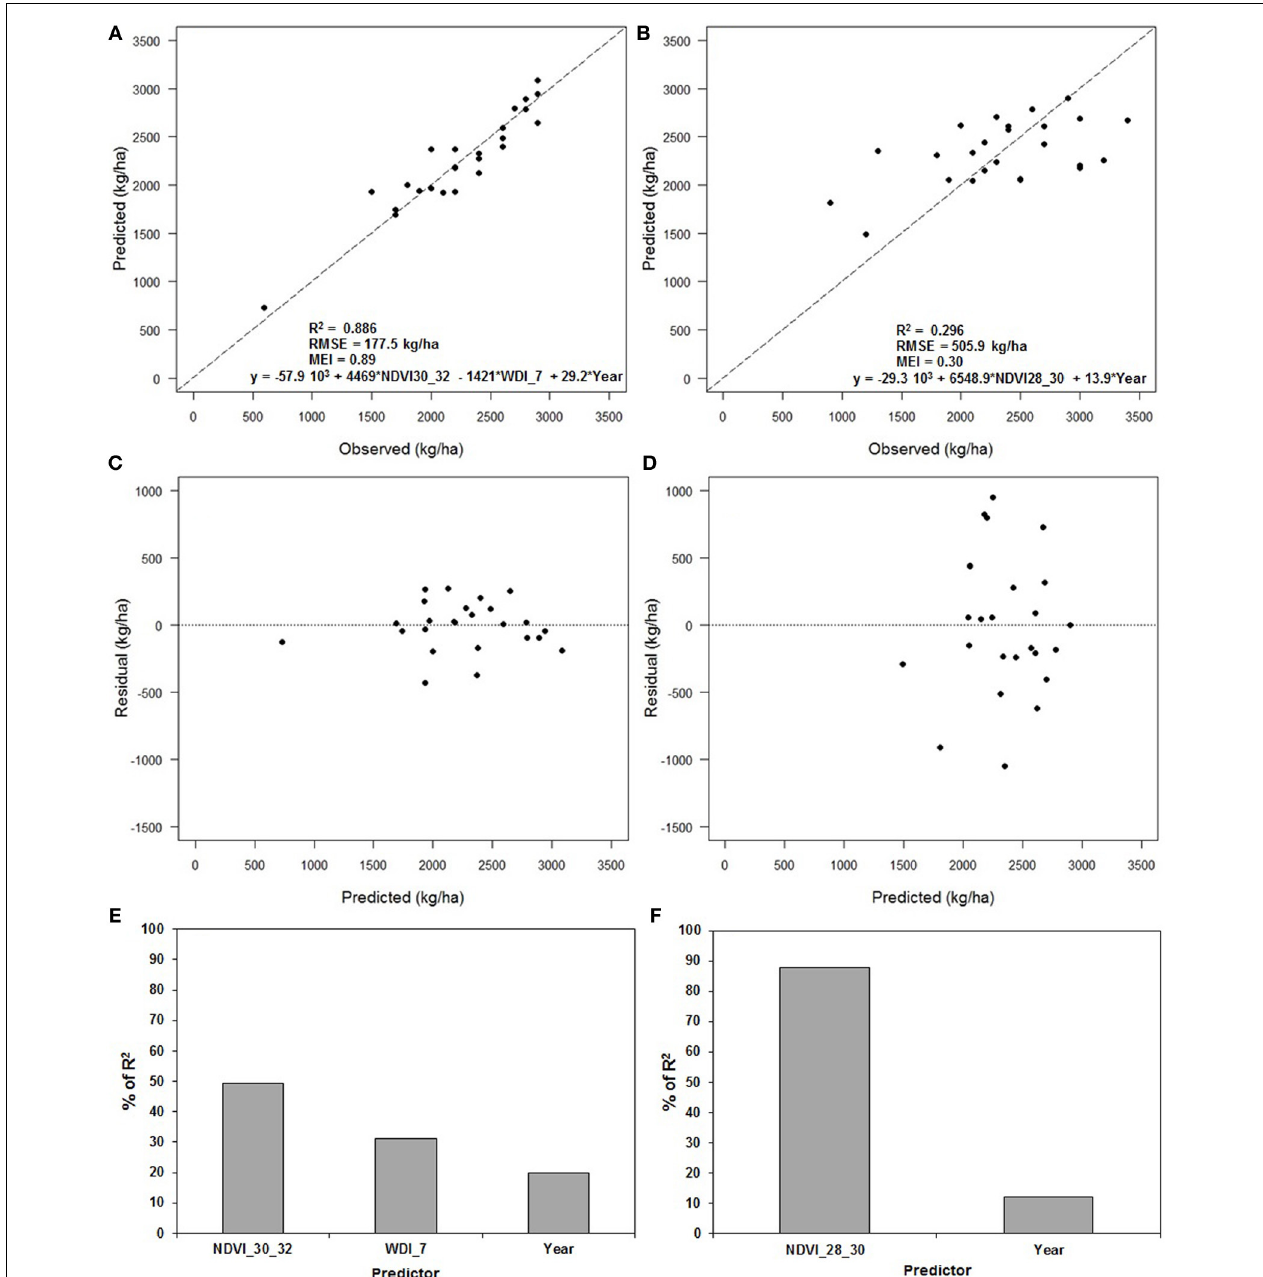
FIGURE 6 | Selected diagnostic results from the multivariate regression of crop yield for the best overall fit (CAR ID 4840, left panels) and worst overall fit (CAR ID 4609, right panels). Scatterplots of observed versus predicted yield (A,B) , residual versus predicted yield (C,D) and the relative